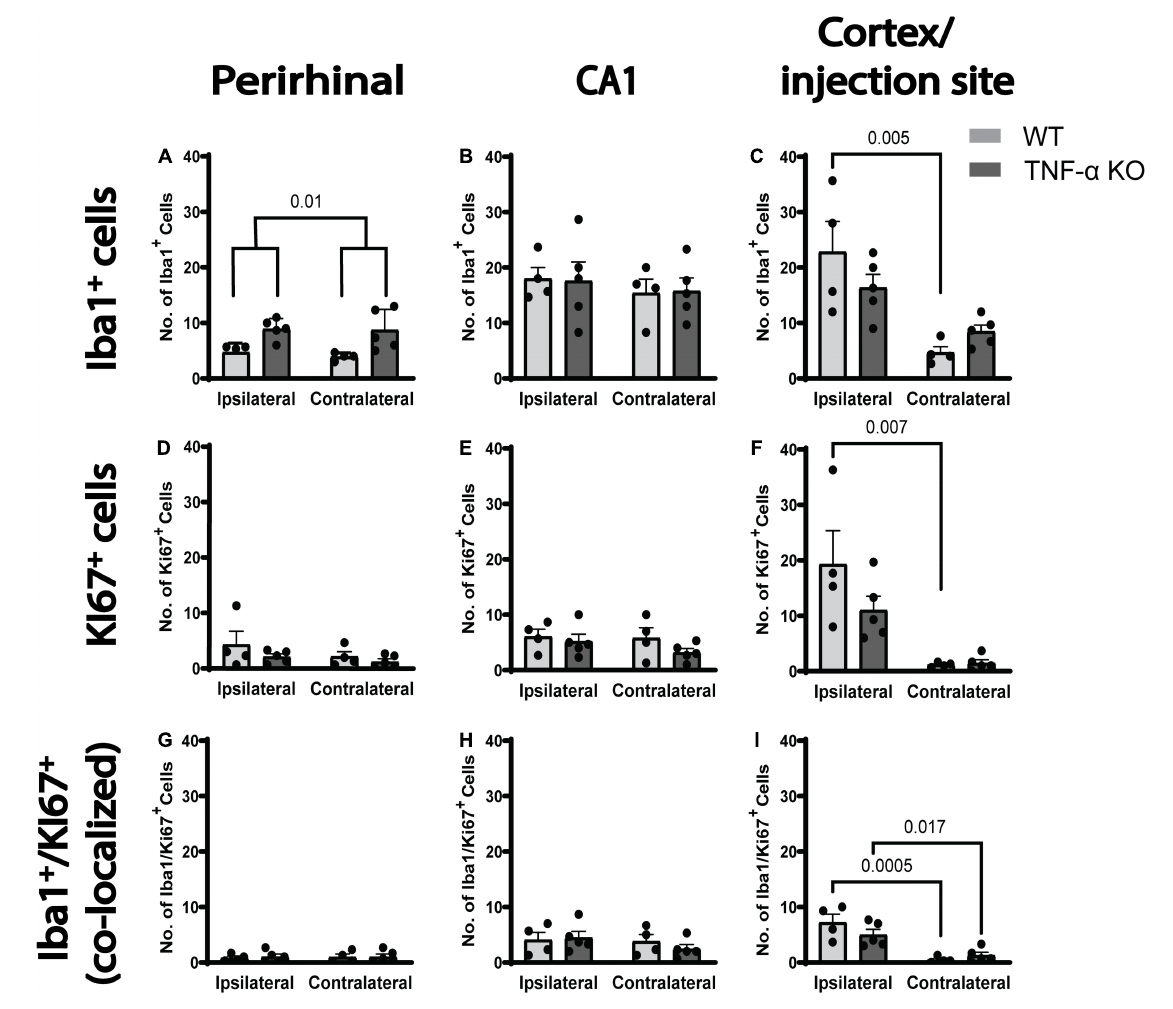
FIGURE2 There were more dividing microglia per field of view in the ipsilateral cortex injection site in both WT and TNF- α KO mice. Cells were quantified in three images and averaged per animal for three regions of interest. (A) Average number of Iba1 + cells (microglia) in the perirhinal cortex, (B) CA1, and (C) cortex/injection site. (D) Average number of KI67 + cells (dividing cells) in the perirhinal cortex, (E) CA1, and (F) cortex/injection site. (G) Average number of co-labeled Iba1 + and KI67 + (dividing microglia) in the perirhinal cortex, (H) CA1, and (I) cortex/injection site. Data are presented as mean ± SEM. Data were analyzed using a two-way ANOVA (see Table 1 ). Statistically significant post hoc comparisons are indicated by bars with corresponding p -values. WT n = 4; TNF- α KO n = 5.